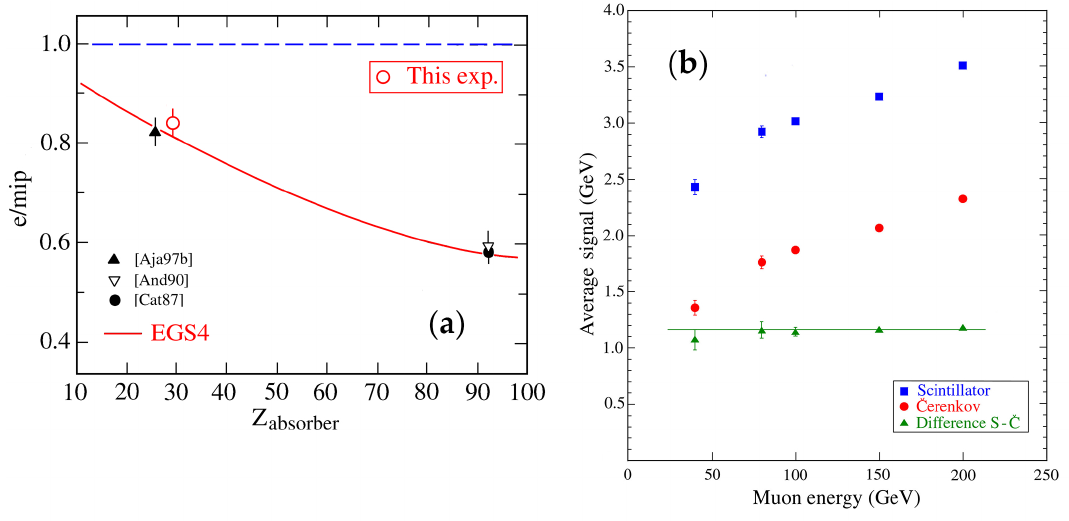
Figure 6. Results of muon detection with the DREAM calorimeter.